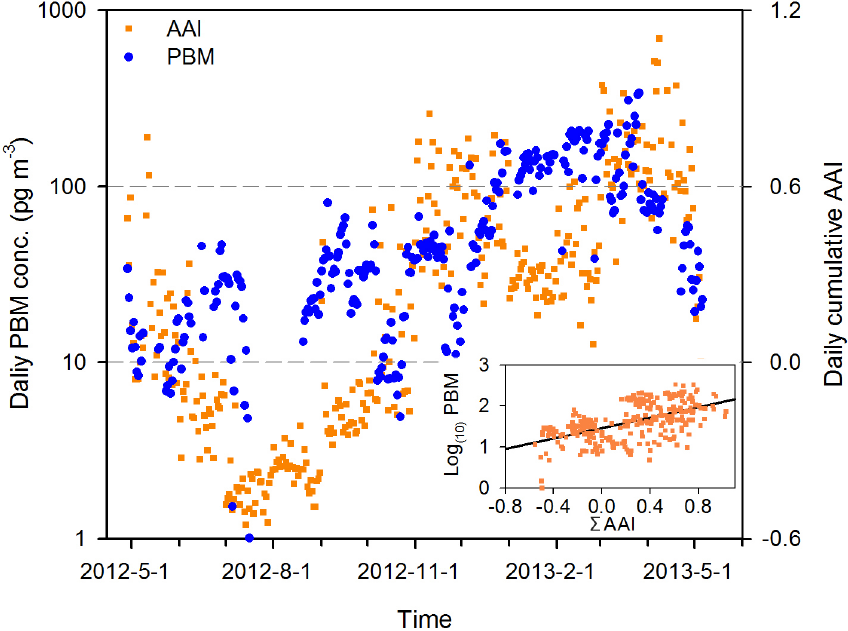
Figure 7. Variations in daily mean PBM concentration and daily cumulative absorbing aerosol index (AAI) during the proceeding 2d at WLG.